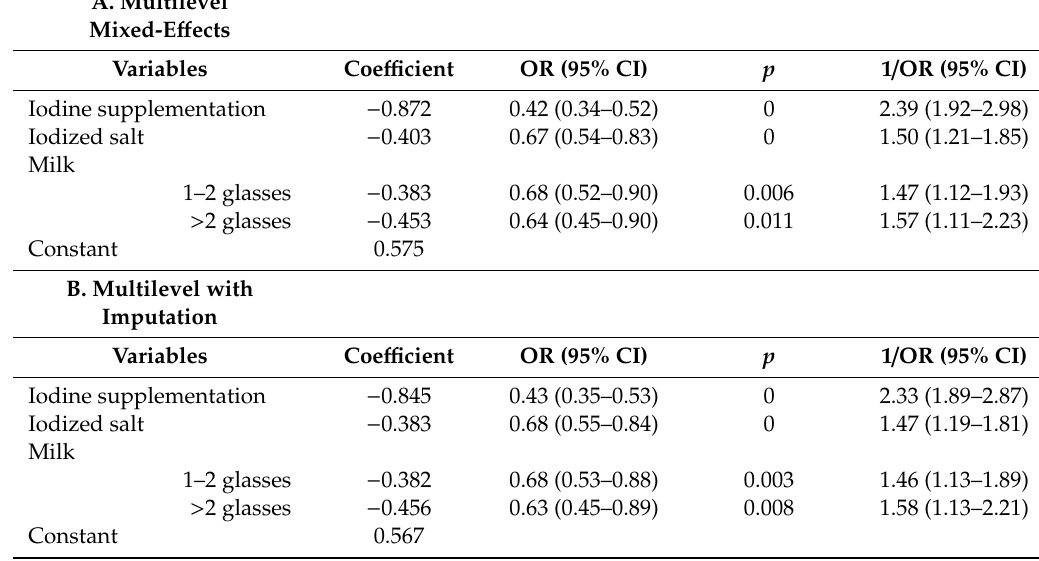
Table 4. Results of multilevel mixed-e ff ects logistic regression models adjusted for paired measures in the 3 trimesters to assess the e ff ect of iodine-rich food intake or supplementation on UIC values < 150 µ g / L.